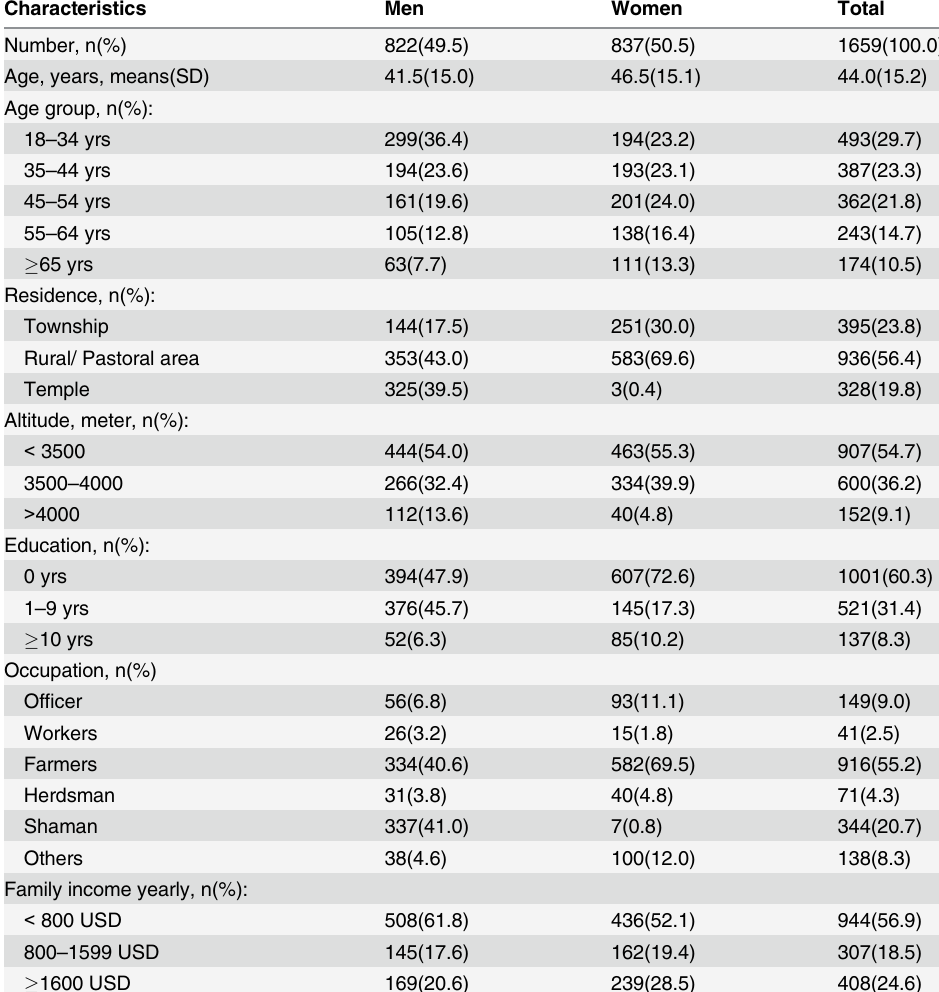
Table 1. The demographic characteristics among Tibetans aged 18 years and over in China.